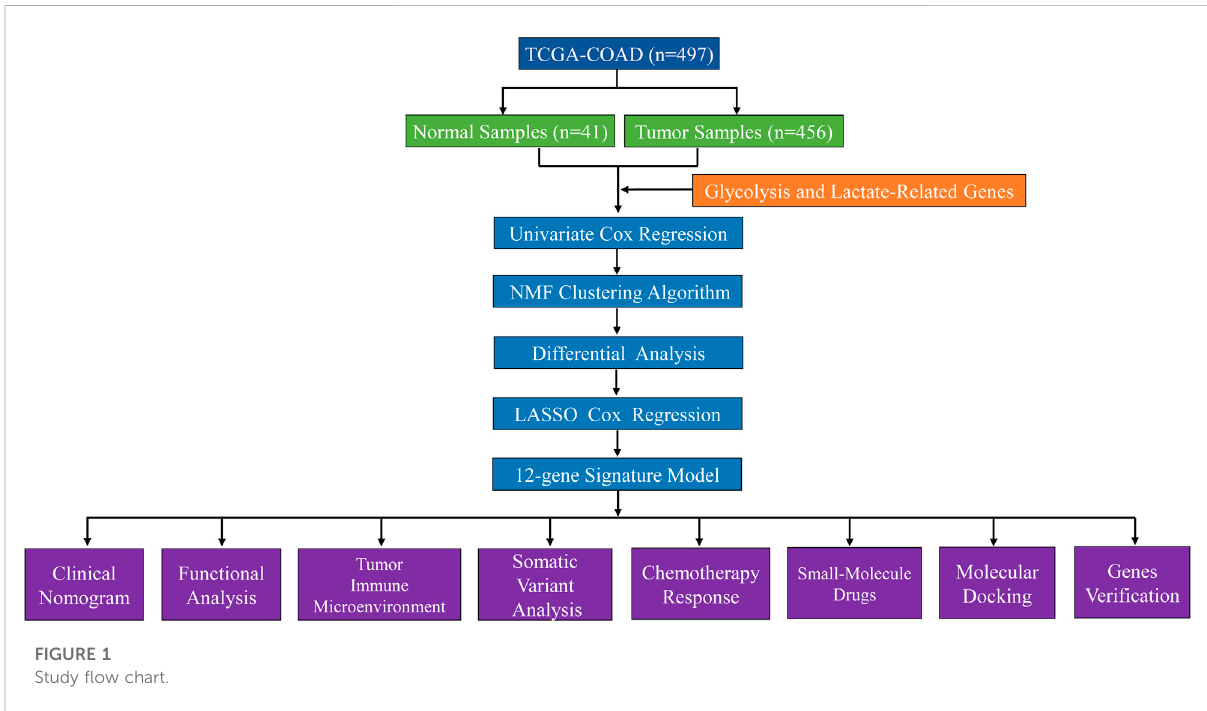
FIGURE 1 Study fl ow